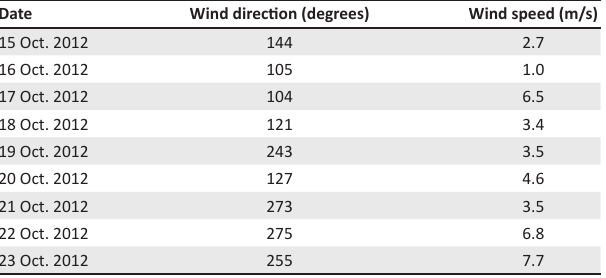
TABLE 2: Average wind data for 15–23 October 2012 recorded at Port Alfred Airport.